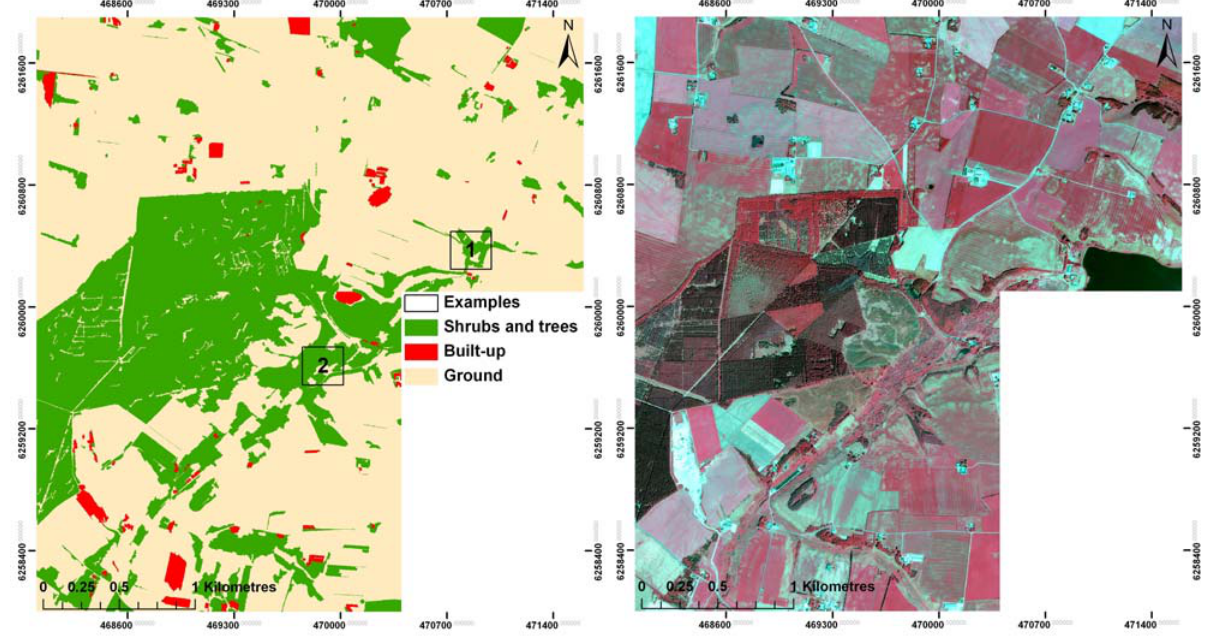
Figure 12. Result of the classification based on the CIR orthoimages and the four features derived from the CART analysis. The marked squares outlined in black demarcate the examples shown in Figures 13–16.